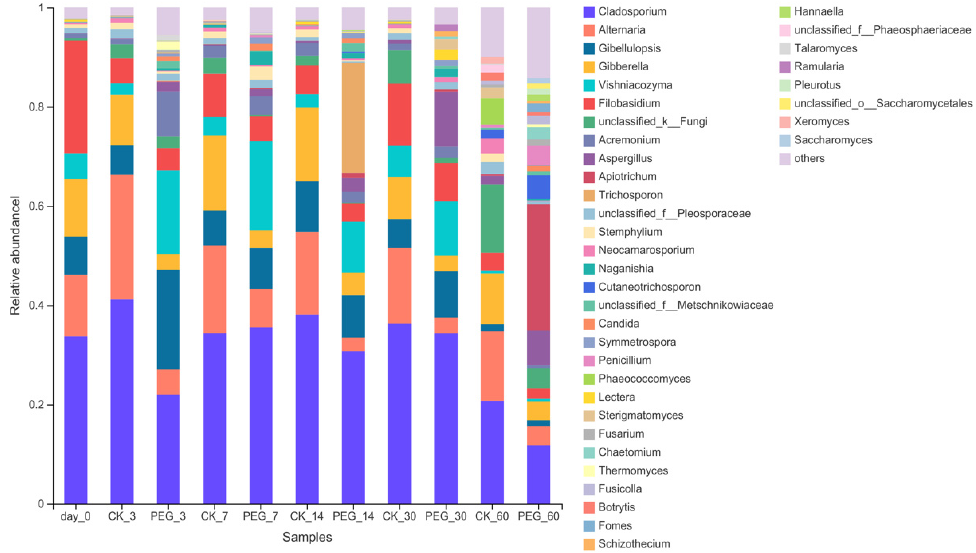
Figure 6. Relative abundance of fungi community on genus level of PEG-treated and control group of ensiled sainfoin (CK_3: on day 3 of control ensiling; PEG_3: on day 3 of PEG-treated ensiling, same as others).